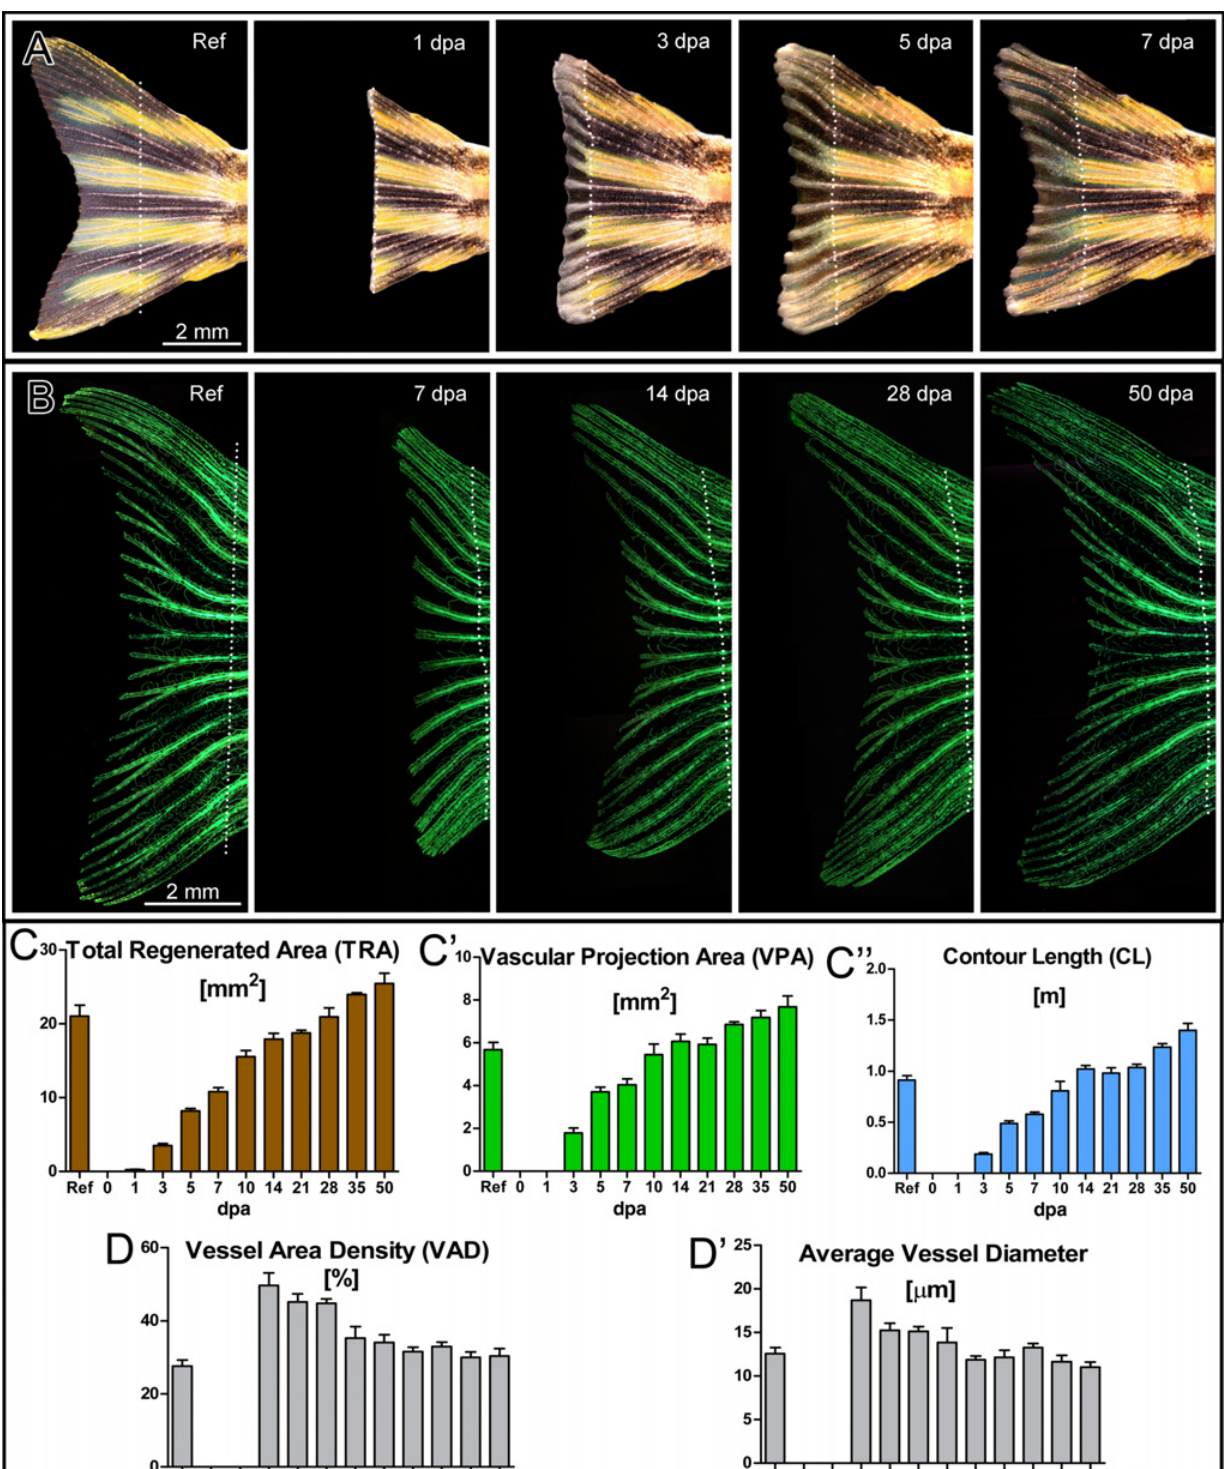
Fig 2. Regeneration of the zebrafish caudal fin and time courses of total regenerated area (TRA), vascular projection area (VPA), vessel wall (contour) length (CL) and their derivatives during regeneration. The process of caudal fin regeneration at multiple time points from reference to 50 dpa: the upper row (A) represents bright field images at reference, 1, 3, 5, and 7 dpa. The second row (B) contains fluorescent images at reference, 7, 14, 28, and